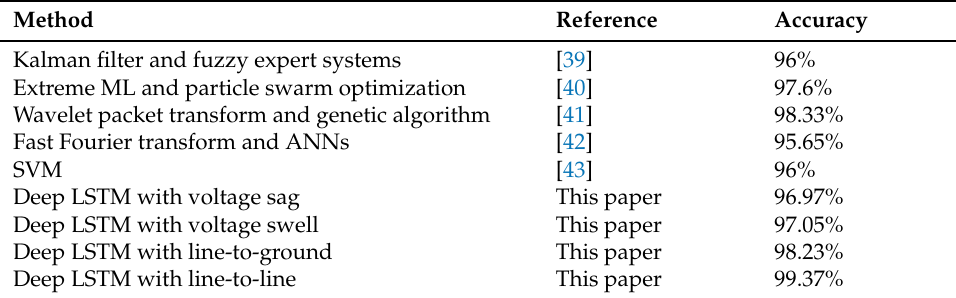
Table 6. Accuracy of some known